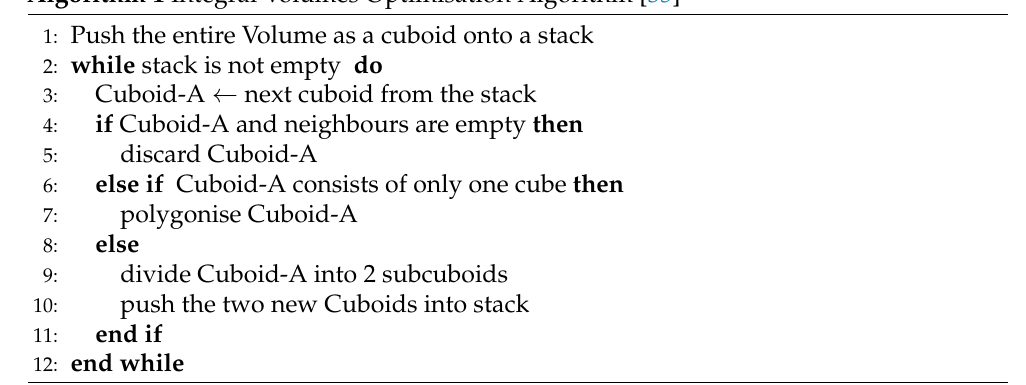
Algorithm 1 Integral Volumes Optimisation Algorithm